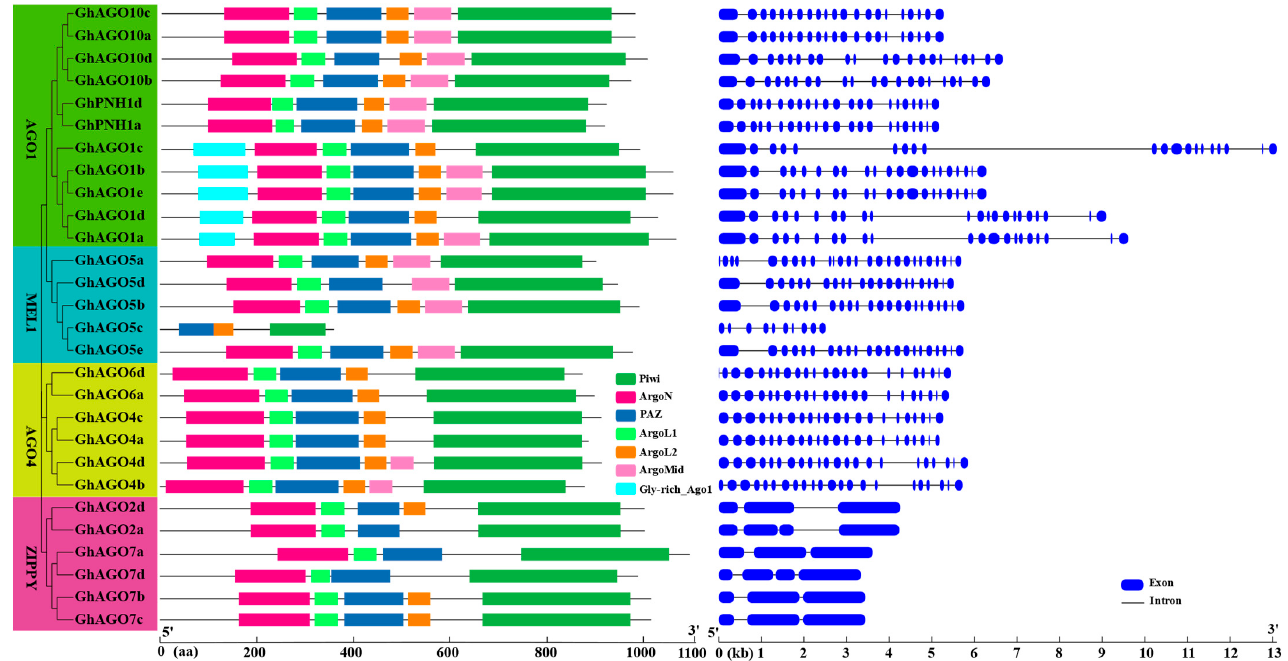
Figure 4. Conserved domains and gene structures of the GbNAC genes. A: Phylogenetic tree of the GhAGO genes. Multiple sequence alignment of the GhAGO proteins was performed using ClustalW. The neighbor-joining (NJ) tree was constructed using MEGA 11 with 1000 bootstrap replicates. B: Conserved domain of the GhAGO genes. The conserved domain of the GhAGO proteins was detected by the HMMER web server (https://www.ebi.ac.uk/Tools/hmmer/search/hmmscan) (accessed on 22 March 2022) using default parameters. C: Gene structure of the GhAGO genes. The blue boxes and black lines represent exons and introns, respectively.